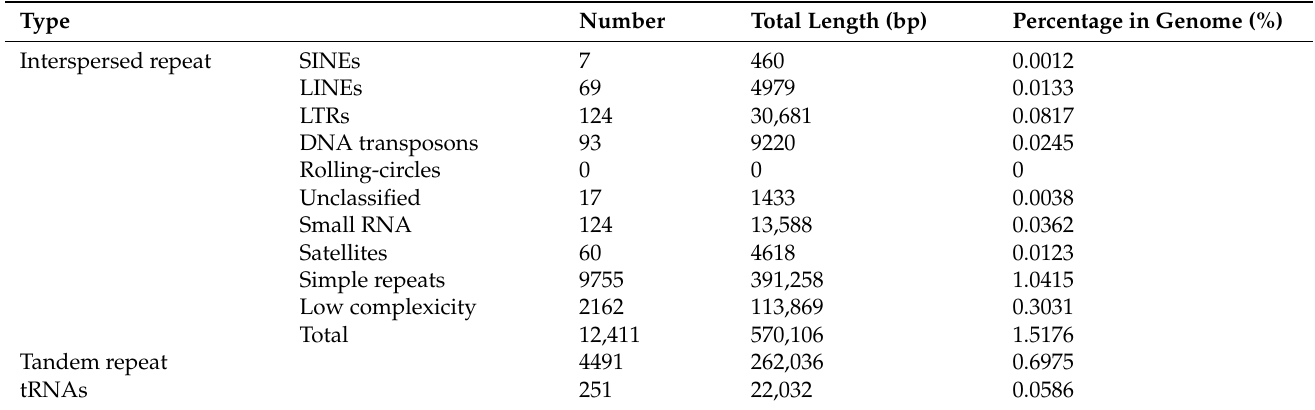
Table 3. Statistical results of repetitive sequences and noncoding RNAs for the Aspergillus affinis CMG 70 genome. SINEs: short interspersed nuclear elements; LINEs: long interspersed nuclear elements; LTRs: long terminal